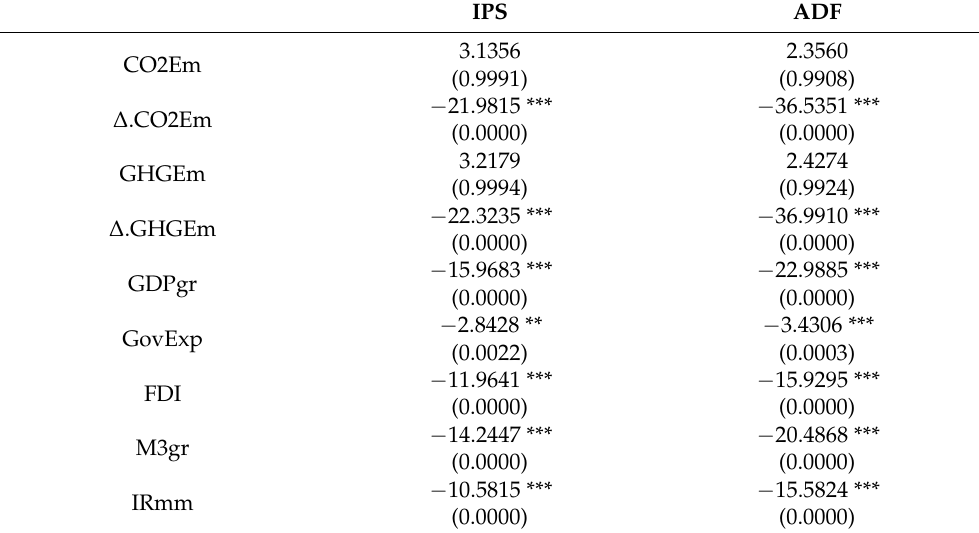
Table 3. Unit-root